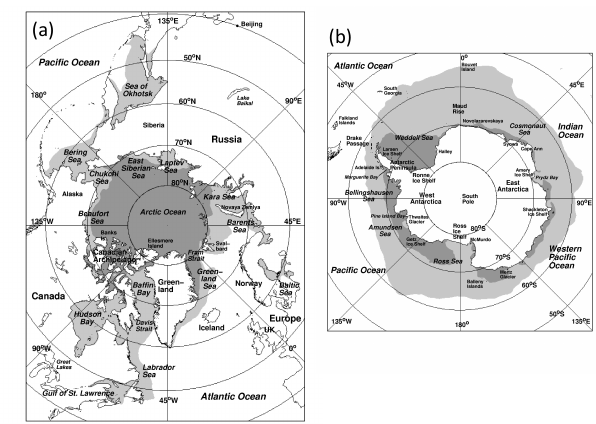
Figure 1. Sea ice cover in winter and summer in (a) the Arctic and (b) the Antarctic. Figure 2. Sea ice cover data over the Sea of Okhotsk using (a) Landsat image on 11 February 2003 and corresponding ice concentration maps from (b) AMSR-E just the 6.25 km high resolution 89 GHz data; (c) AMSR-E using the standard data product generated at 12.5 km resolution; and (d) SSM/I using the historical time series grid at 25